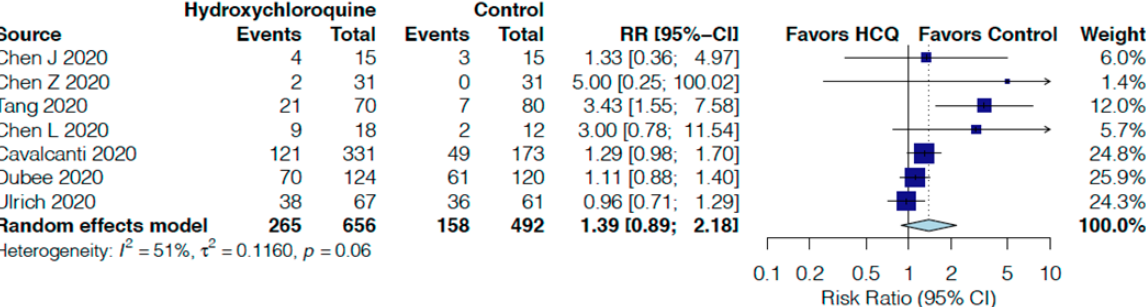
Figure 4. Effect of hydroxychloroquine on all-cause mortality at 30 days in hospitalized COVID-19 patients.